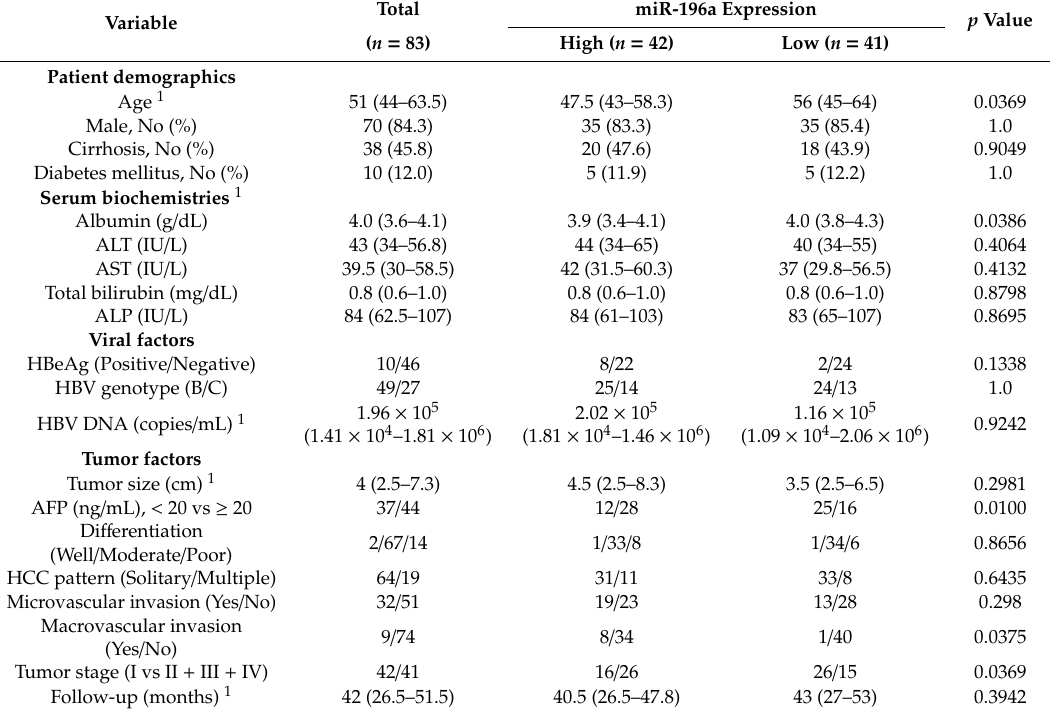
Table 1. Correlation of high and low expression of miR-196a with clinical, pathological, and serological features of patients with hepatocellular